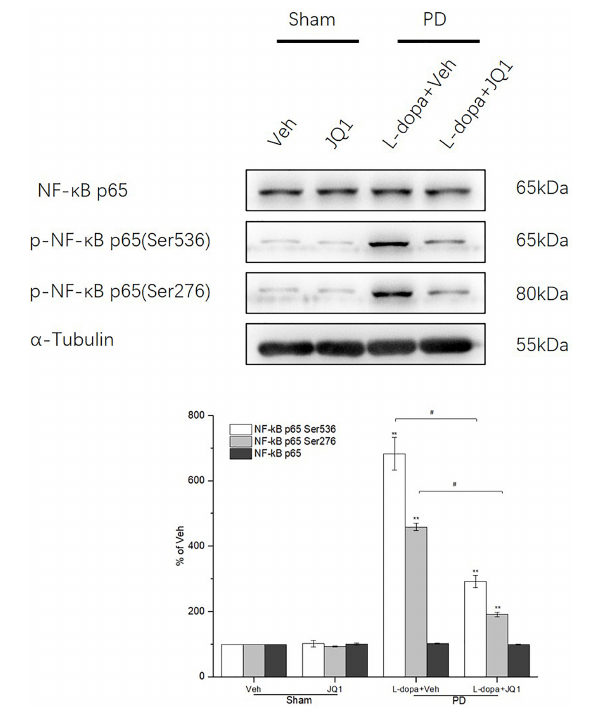
FIGURE 9 | Changes in the ratio of nuclear NF- κ B p65 to cytoplasmic NF- κ B p65 in the saline- or 6-OHDA-lesioned striatum after 21 days of administration. Intermittent L-dopa stimulation induced a significant increase in the ratio of nuclear NF- κ B p65 to cytoplasmic NF- κ B p65 in the 6-OHDA-lesioned striatum from both L-dopa and L-dopa + JQ1 treatment groups ( p < 0.001 vs. Veh group). Moreover, the ratio of nuclear NF- κ B p65 to cytoplasmic NF- κ B p65 in L-dopa treatment group was statistically higher than that in the L-dopa + JQ1 treatment group ( p < 0.001). JQ1 barely affected the ratio in the saline-lesioned striatum in the JQ1 treatment group. The protein levels expressed relative to α -tubulin levels. The data are expressed in terms of mean ± SD and as a percentage of the Veh group. ** p < 0.001 vs. Veh group; # p < 0.01 vs. L-dopa treatment group ( n = 6 per group, the repetition no. = 3).